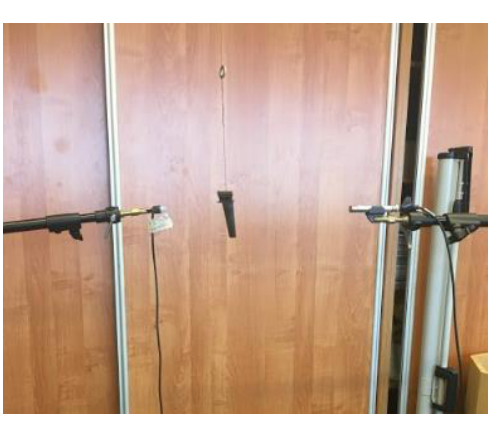
Fig. 2. Diagram of the test stand